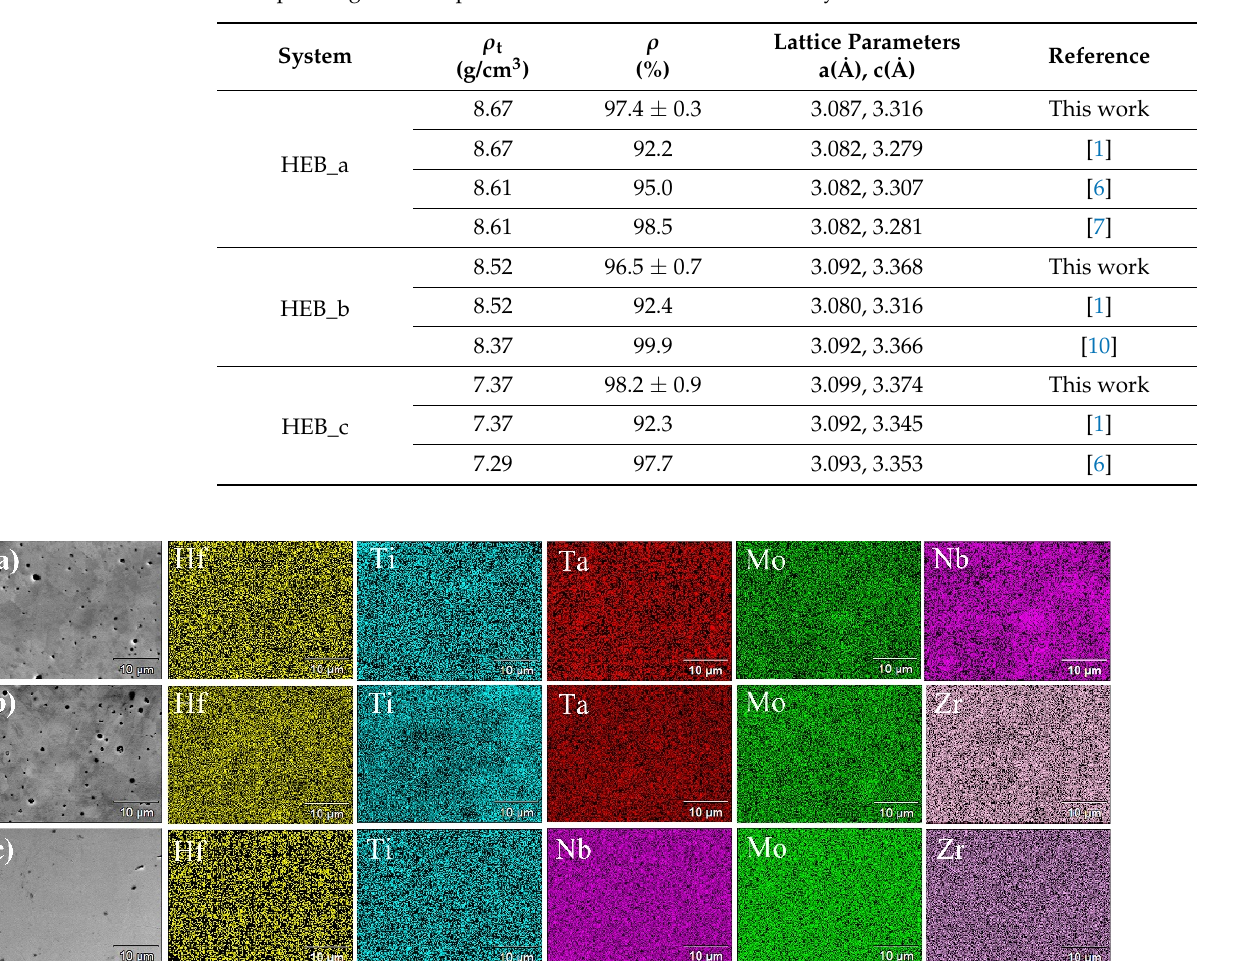
Table 4. Density and lattice parameters of the three HEB products obtained by SPS in this work. The corresponding values reported in the literature for the same systems are also included.